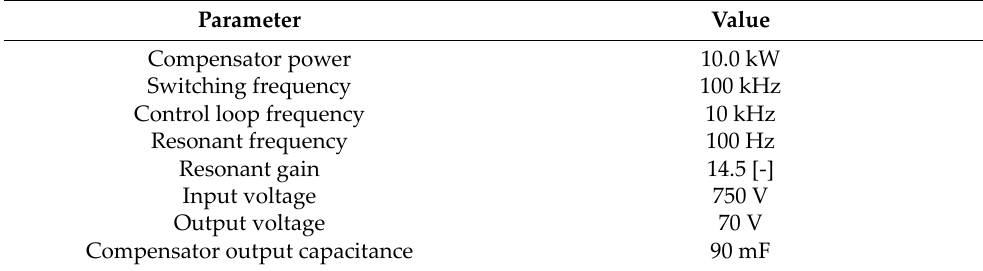
Table 1. Key compensator